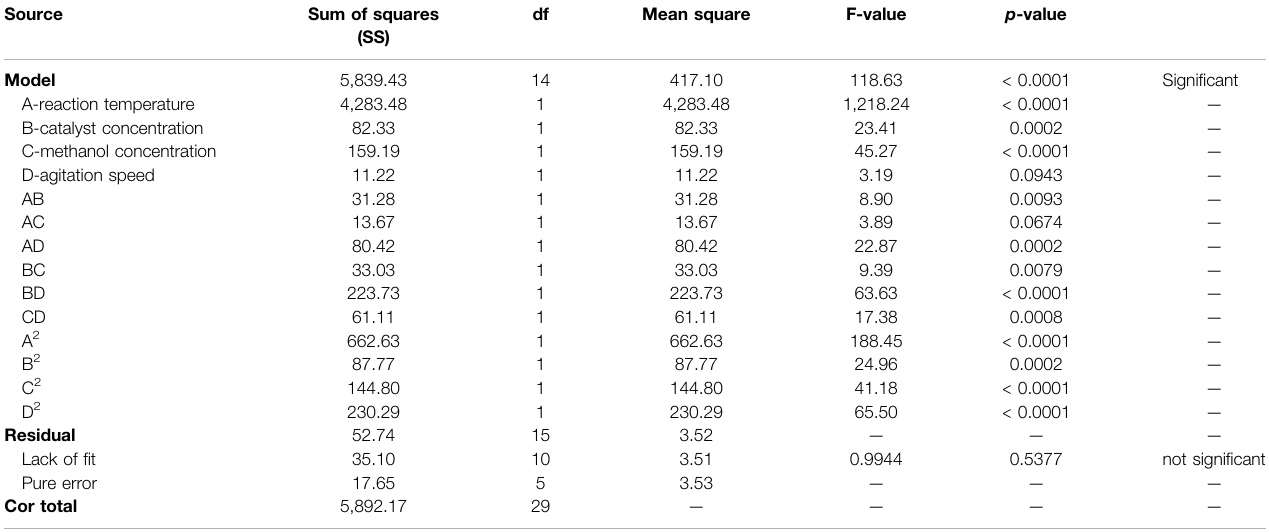
TABLE 6 | ANOVA results from esteri fi cation of castor oil Source